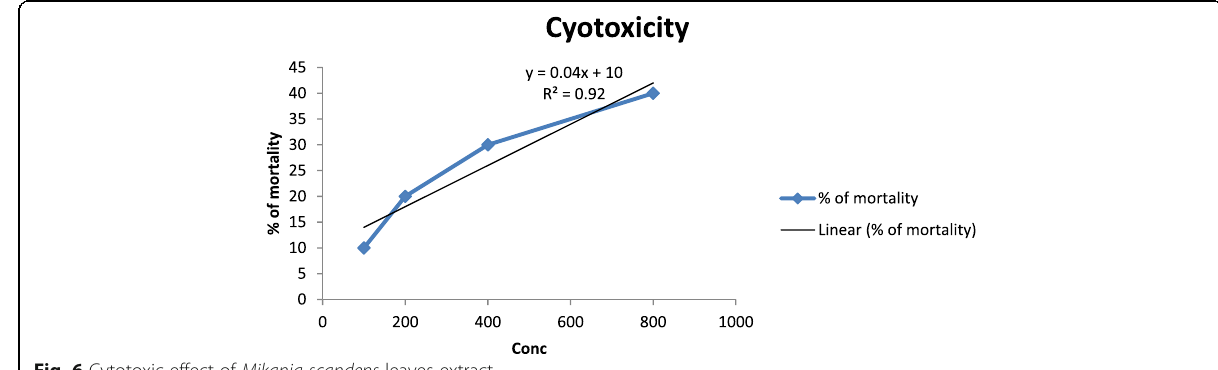
Fig. 6 Cytotoxic effect of Mikania scandens leaves